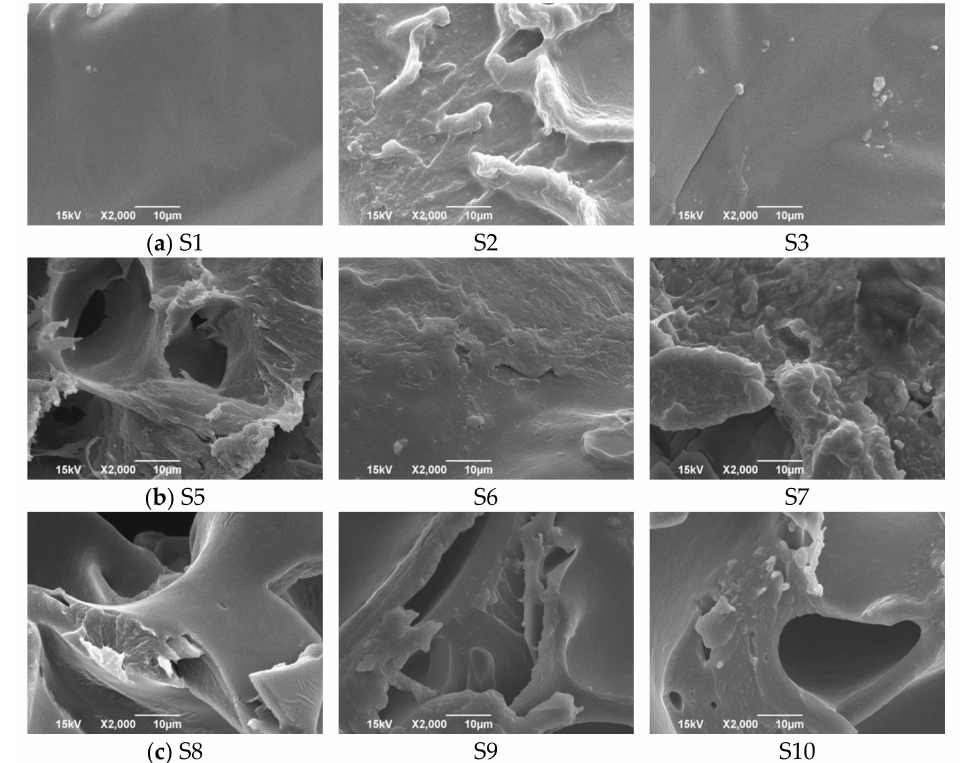
Figure 2. SEM Photomicrographs of the investigated substrates: ( a ) subset I; ( b ) subset II and ( c ) subset III.